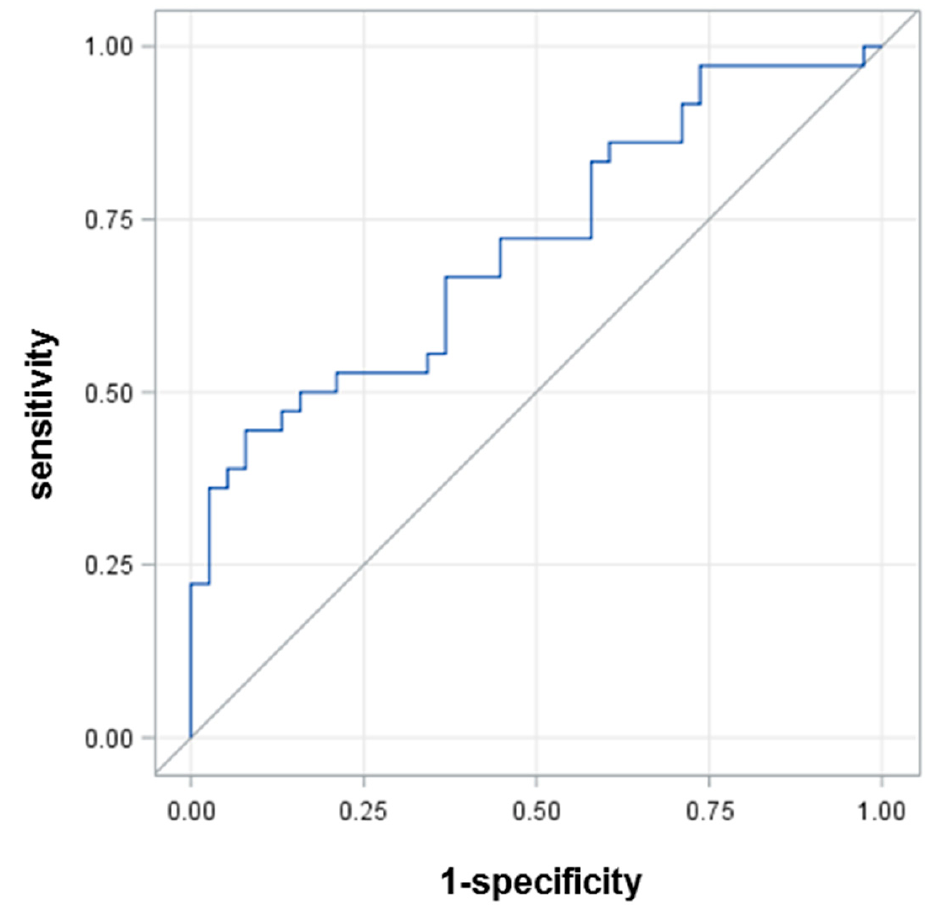
Figure 3. ROC curve for HSA-SH.